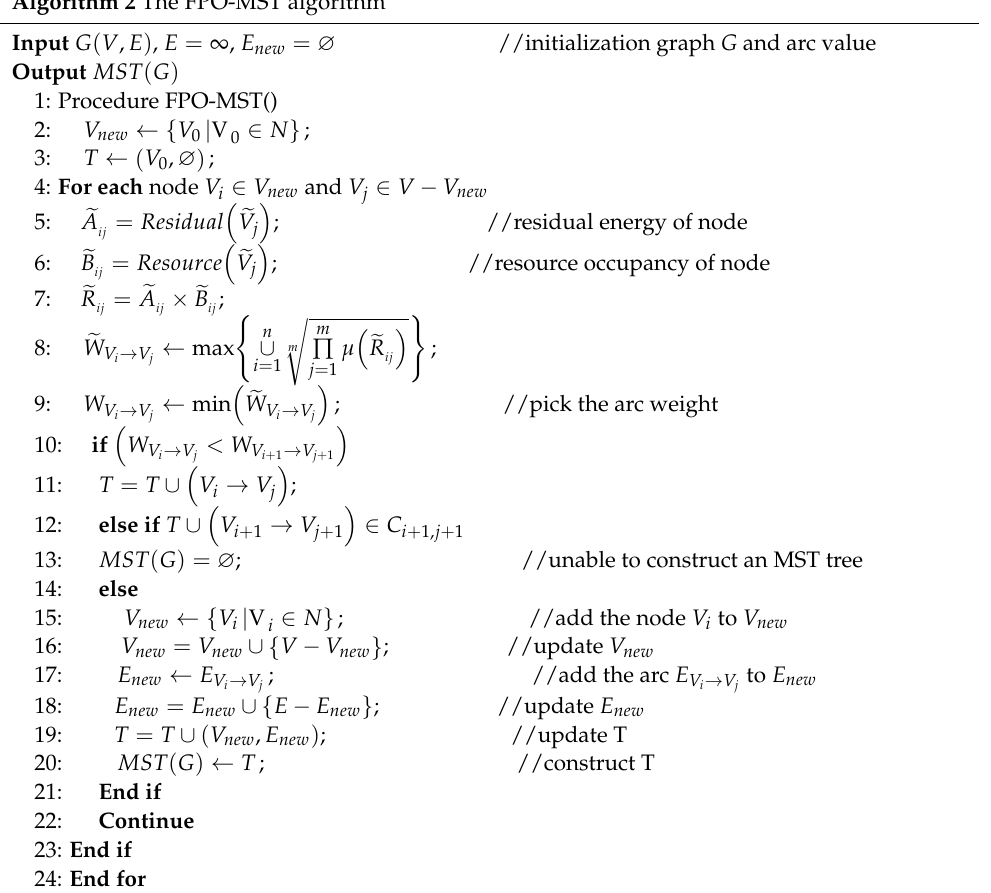
Algorithm 2 The FPO-MST